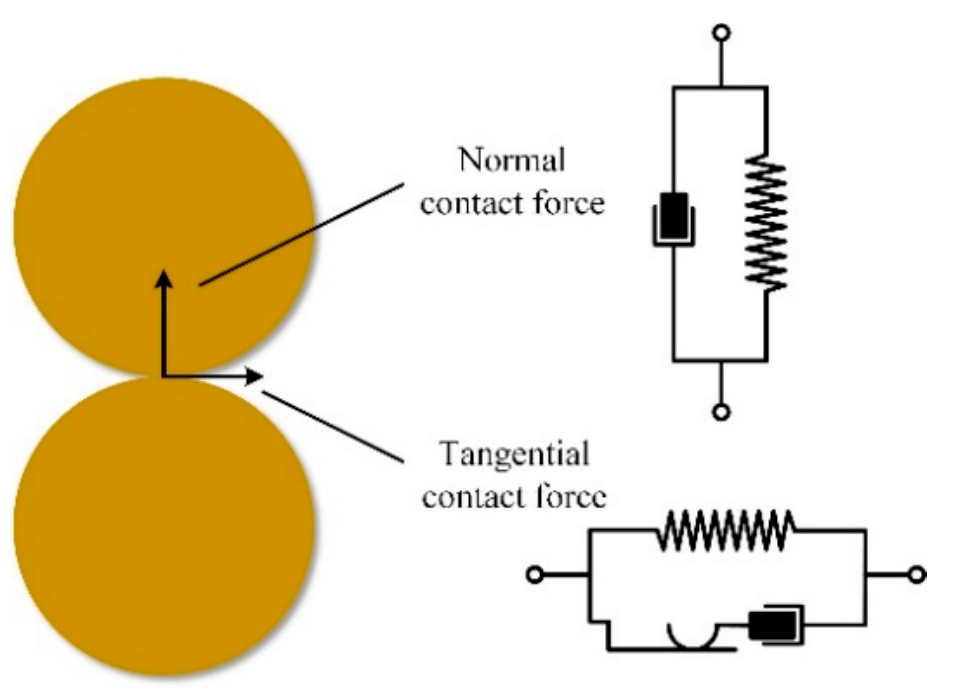
Figure 1. Hertz–Mindlin no-slip model. The contact forces include contact force amplitude and damping force. The normal contact force amplitude F e and tangential contact force amplitude F e are the function of N T normal overlap δ N and tangential overlap δ T , respectively, and mainly consider the elastic response during collision. The expressions are shown in Equation (5):